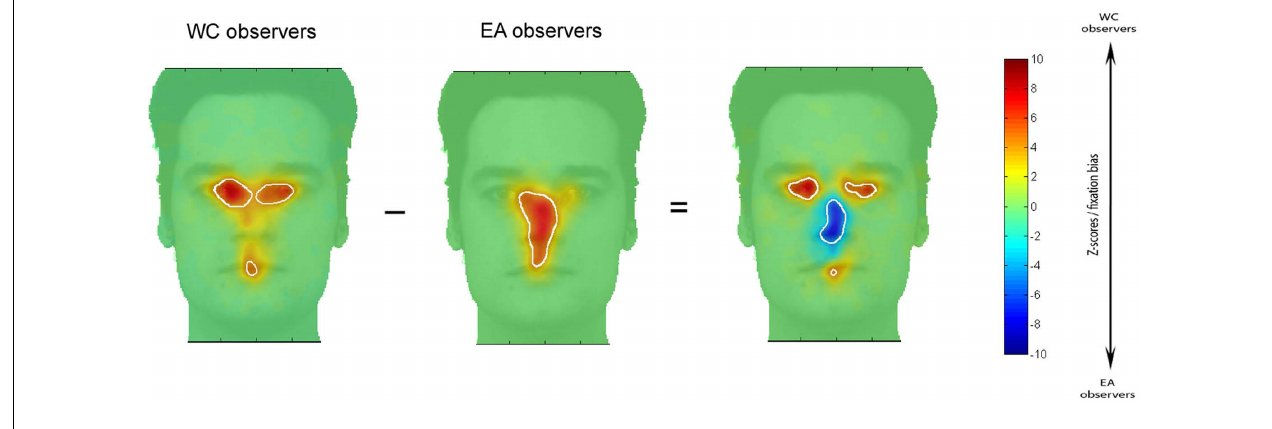
of significantly longer fixation durations than were observed for other areas; on the difference map, white contours indicated regions of significant differences between the EA andWC maps (i.e., fixation